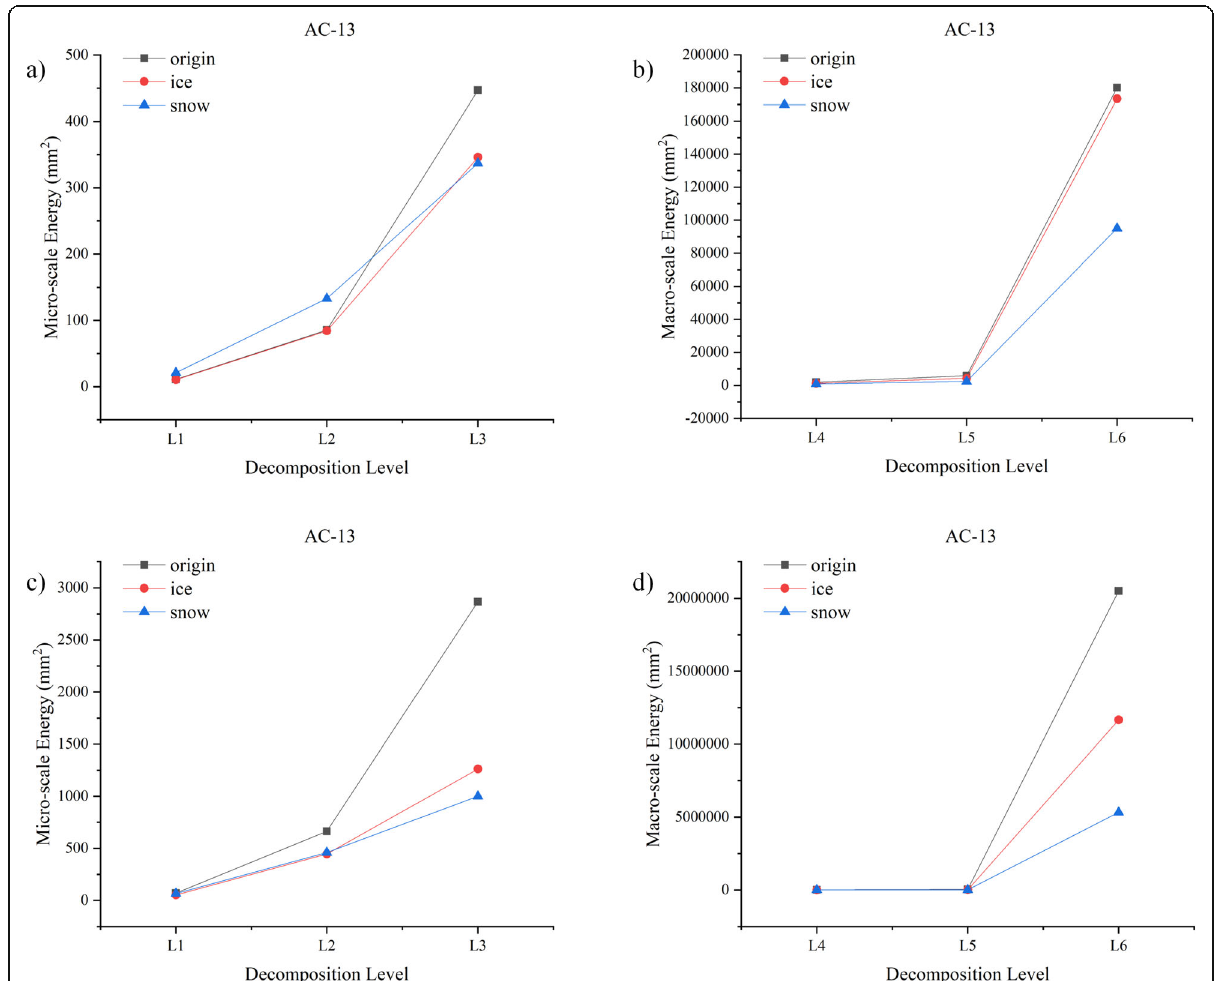
Fig. 8 The Energy Results of AC-13; a 50% Cutting Plane in micro-scale, b 50% Cutting Plane in macro-scale, c 100% Cutting Plane in micro-scale, d 100% Cutting Plane in